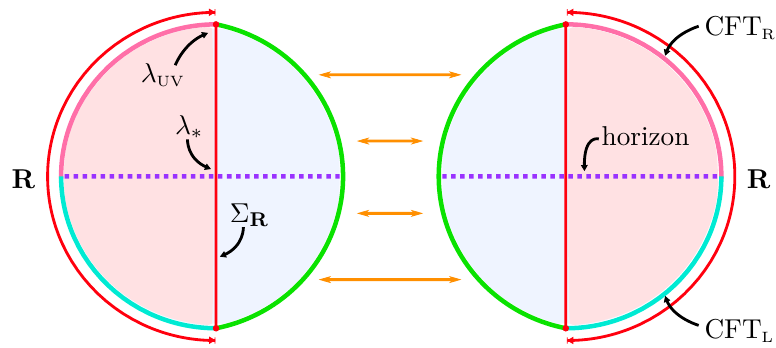
Figure 10. The RT surface of an entangling surface located at the defect in the no-island